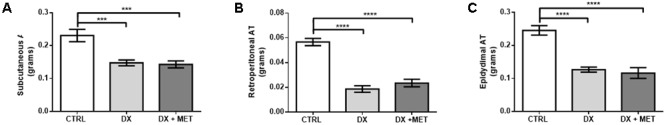
Weight of subcutaneous AT (A), retroperitoneal AT (B), and epididymal AT (C): mice were injected with doxorubicin hydrochloride (DX) or saline (CTRL) i.p. twice a week for 2 weeks, and a subset received a daily oral gavage of metformin (DX + MET). Data are presented as means ± SD (n = 11). The groups were compared using one-way ANOVA followed by Bonferroni’s post hoc tests ∗∗∗p ≤ 0.001 and ∗∗∗∗p ≤ 0.0001.